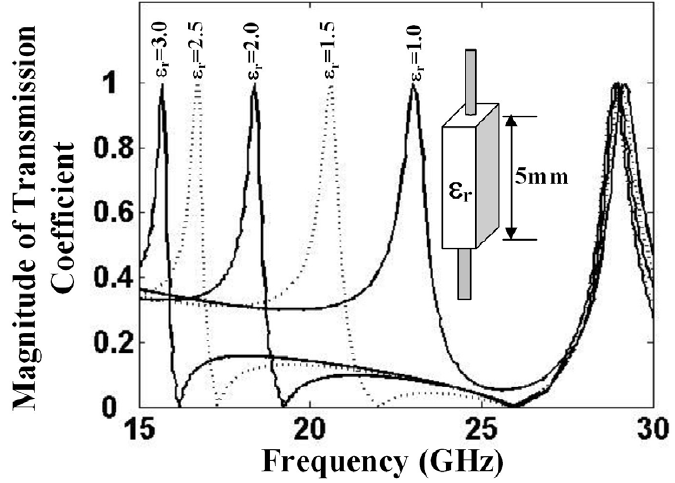
Figure 5. Transmission coefficients for wire-loaded waveguide cavity with the wire covered with different values of permittivities (reproduced from [16] with the authors’ permission).